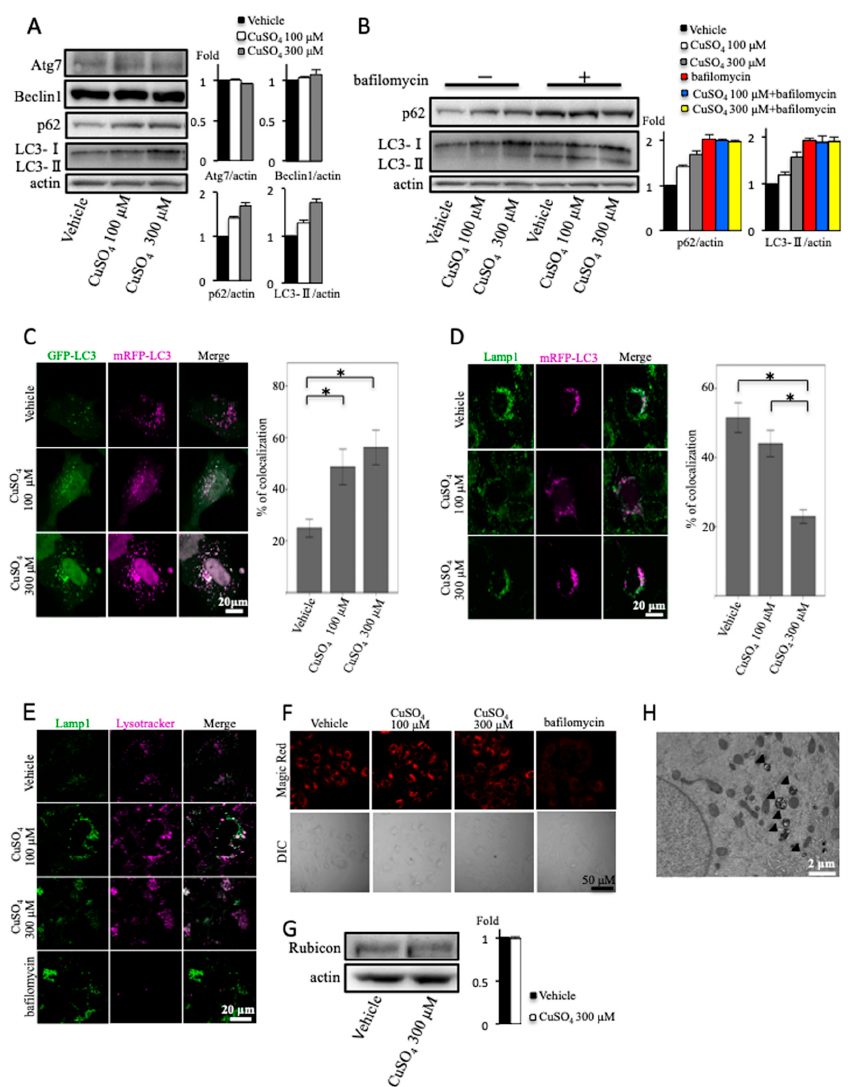
Figure 2. E ff ect of copper on autophagy. ( A ) OUMS-29 cells were treated with copper at concentrations of 100 or 300 μ M for 12 h. Densitometry analysis of indicated proteins is shown on the right. ( B ) Light chain 3 (LC3) turnover assay. OUMS-29 cells were treated with copper at concentrations of 100 or 300 μ M for 12 h with or without 50 nM of bafilomycin A1. Densitometry analysis of indicated proteins is shown on the right. ( C ) OUMS-29 cells were transfected with monomeric red fluorescent protein (mRFP)–green fluorescent protein (GFP) tandem fluorescent-tagged LC3 plasmids, and were treated with copper at concentrations of 100 or 300 μ M for 12 h. Colocalizations of mRFP and GFP signals were measured by counting an overall total of 30 to 40 cells over the course of three independent experiments. Colocalization was shown as the percentage of merged signals in the total number of mRFP signals. Data are expressed as means ± SEM. ( D ) OUMS-29 cells were transfected with mRFP-LC3, and were treated with copper at concentrations of 100 or 300 µ M for 12 h. Then, immunofluorescence staining for lysosomal-associated membrane protein 1 (Lamp1) was performed. ( E ) E ff ect of copper on lysosomal function. OUMS-29 cells, treated with copper at concentrations of 100 or 300 µ M with or without bafilomycin A1 (50 nM) for 12 h, were loaded with 1 µ M lysotracker Red for 1 h, followed by fixation, and then immunofluorescence staining for Lamp1 was performed. ( F ) E ff ect of copper on lysosomal function. OUMS-29 cells, treated with copper at concentrations of 100 or 300 µ M with or without bafilomycin A1 (50 nM) for 12 h, were loaded with Magic Red Cathepsin B reagent for 1 h, and then analyzed by microscopy. ( G ) Huh7 cells were treated with copper at the concentration of 300 µ M for 12 h. Densitometry analysis of indicated proteins is shown on the right. ( H ) Transmission electron micrograph of a Wilson disease patient. Arrowheads indicate the